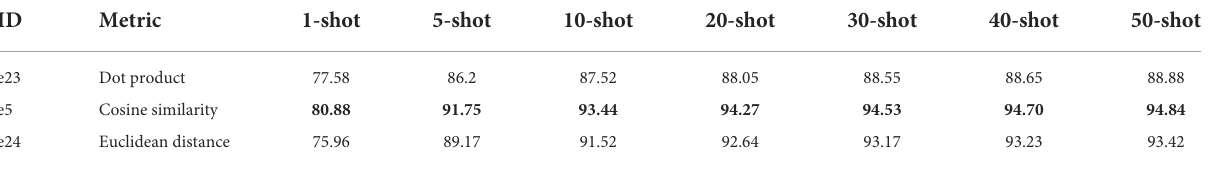
TABLE 6 The results of different distance metrics.